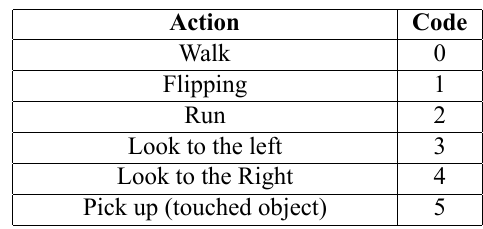
Table 2. Action codes.